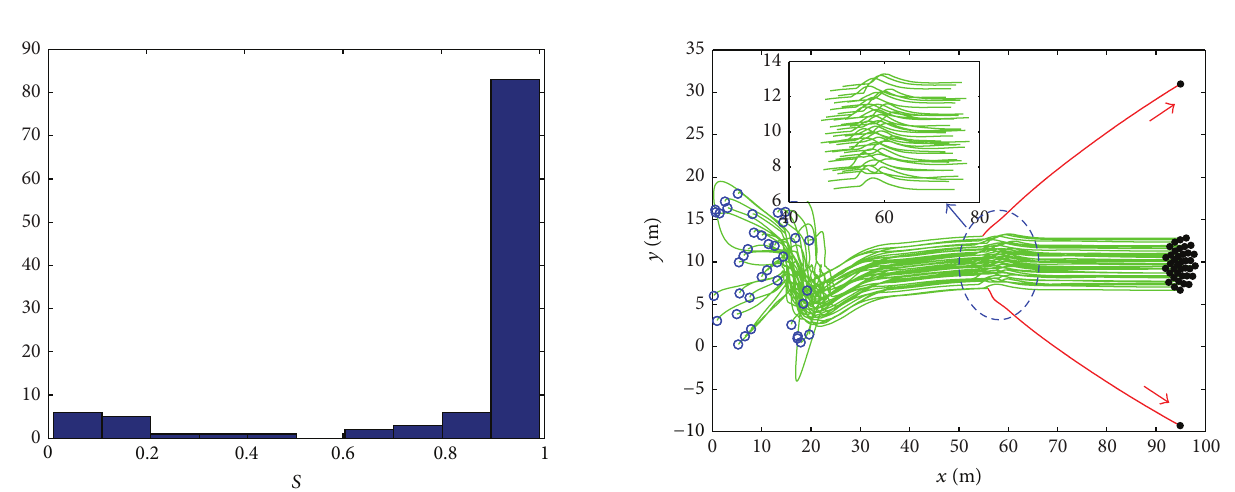
Figure 7: Histogram statistics for the size ratio of the separated subgroups.